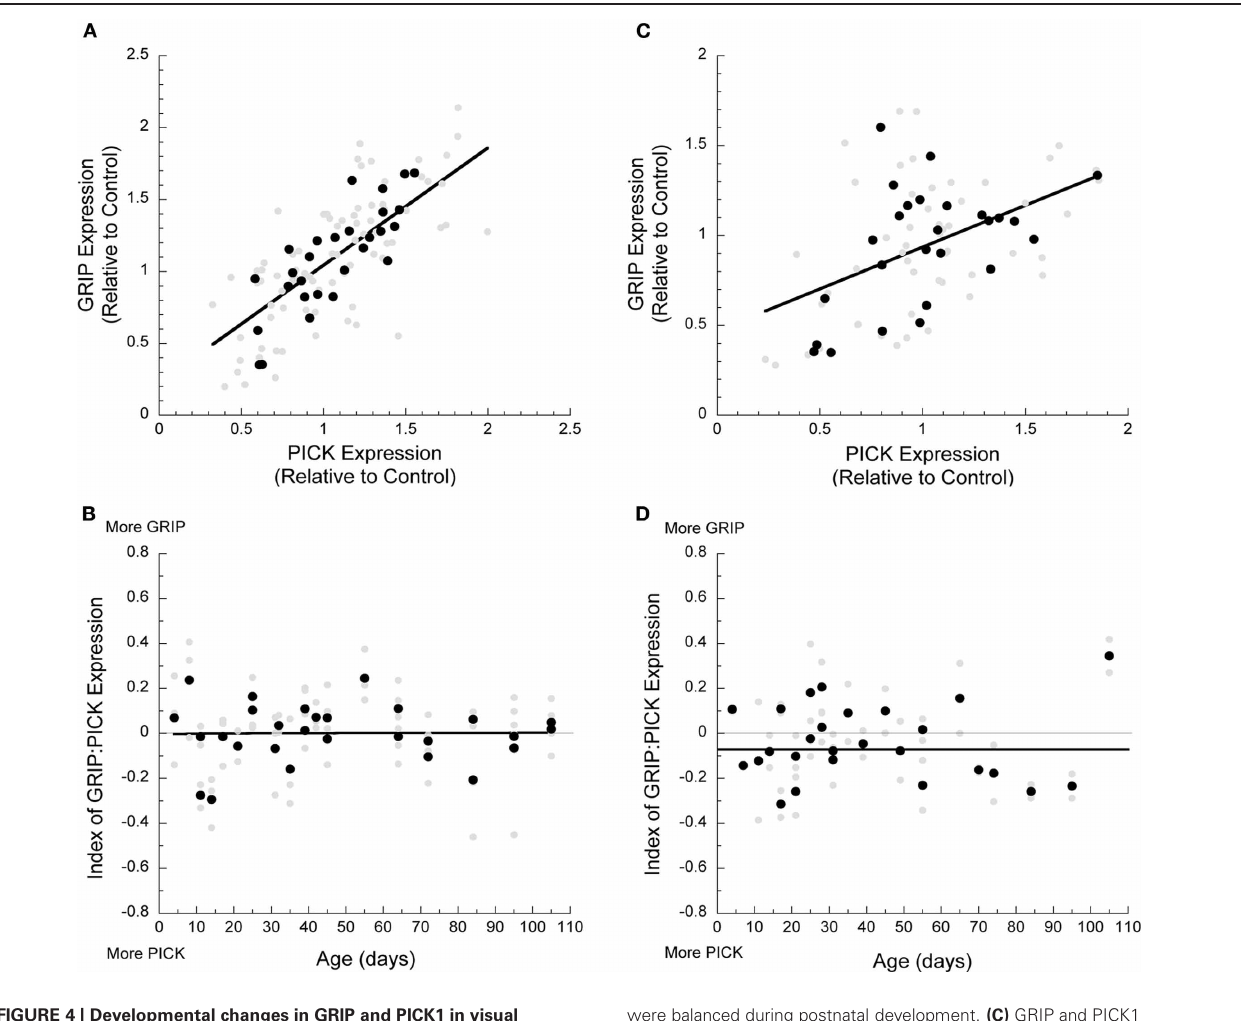
FIGURE 4 | Developmental changes in GRIP and PICK1 in visual and frontal cortex. (A) GRIP and PICK1 expression in visual cortex was highly correlated during development ( r = 0.72, p < 0 . 0001). (B) The index of GRIP:PICK1 expression showed that the two proteins